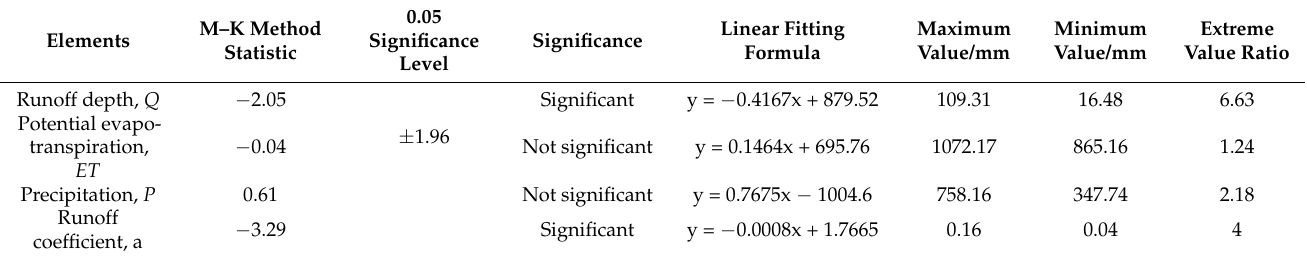
Table 3. M–K test for hydrometeorological elements in the Weihe River basin.